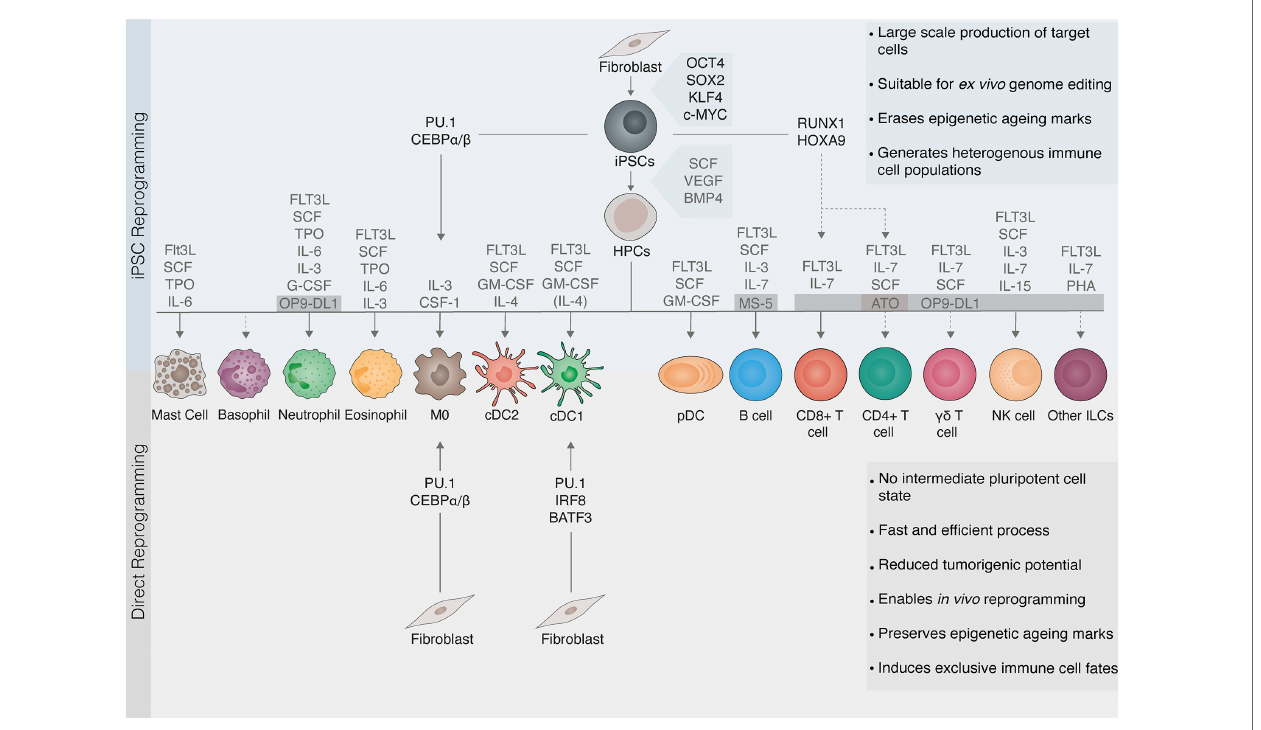
FIGURE 2 | Cell reprogramming as a source of immune cells. Cellular reprogramming provides an opportunity to generate tailored immune cells for immunotherapy. Somatic cells can be reprogrammed to induced pluripotent stem cells (iPSCs) with the transcription factors OCT4, SOX2, KLF4, and c-MYC. iPSCs are then differentiated to hematopoietic progenitor cells (HPCs) with the cytokines stem cell factor (SCF), vascular endothelial growth factor (VEGF), and bone morphogenetic protein 4 (BMP4). Protocols for the differentiation of HPCs into myeloid and lymphoid lineages involve exposing cells to complex cytokine cocktails and/or feeder layers including MS-5, OP9- DL1, or arti fi cial thymic organoids (ATO) supporting lymphopoiesis. Due to the self-renewal capacity of pluripotent stem cells, iPSC reprogramming (top panel) can generate immune cells on a large scale and is suitable for ex vivo genome editing. Cells undergo rejuvenation and erasure of epigenetic marks associated with aging or exhaustion. However, iPSC differentiation into mature immune cells is challenging (dashed lines) and leads to the generation of heterogeneous populations. Direct reprogramming (also known as transdifferentiation, bottom panel) refers to a change in cell fate mediated by lineage transcription factors that, unlike in iPSC reprogramming, does not involve pluripotent intermediates. The direct reprogramming of fi broblasts to macrophages (MØ) or conventional dendritic cells type 1 (cDC1) induce exclusively the target immune cell fate. Direct reprogramming is a faster and more ef fi cient process. It can be elicited both in vitro and within the target tissue, thus having potential for in vivo reprogramming. It also reduces tumorigenic risks from contaminating stem cells. Moreover, direct reprogramming may retain epigenetic aging hallmarks, making it more suitable for modeling aging-related disease but more dif fi cult to achieve complete epigenetic reprogramming. Transcription factors can also be applied to accelerate and direct the differentiation of iPSCs (also known as forward reprogramming, top panel). FLT3L, Fms-like tyrosine kinase 3 ligand; TPO, Thrombopoietin; IL, interleukin; G-CSF, granulocyte colony- stimulating factor; GM-CSF, granulocyte-macrophage colony-stimulating factor; cDC2, conventional dendritic cells type 2 DCs; pDCs, plasmacytoid DCs; NK, natural killer; ILCs, innate lymphoid